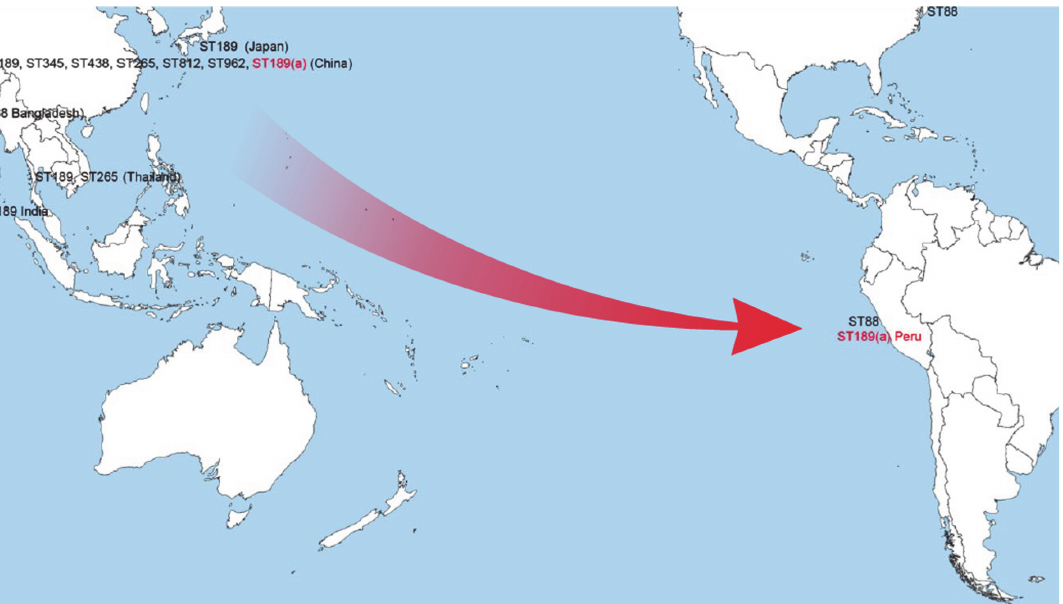
Fig 3. Sequence types (STs) identified at both side of the Pacific Ocean and route for the movement of waters associated with El Ni ñ o event (red arrow). STs in red indicate those genetic variants detected both in Asia and Peru (ST189a), including the ST189 for the strain 090 – 96 with the recA